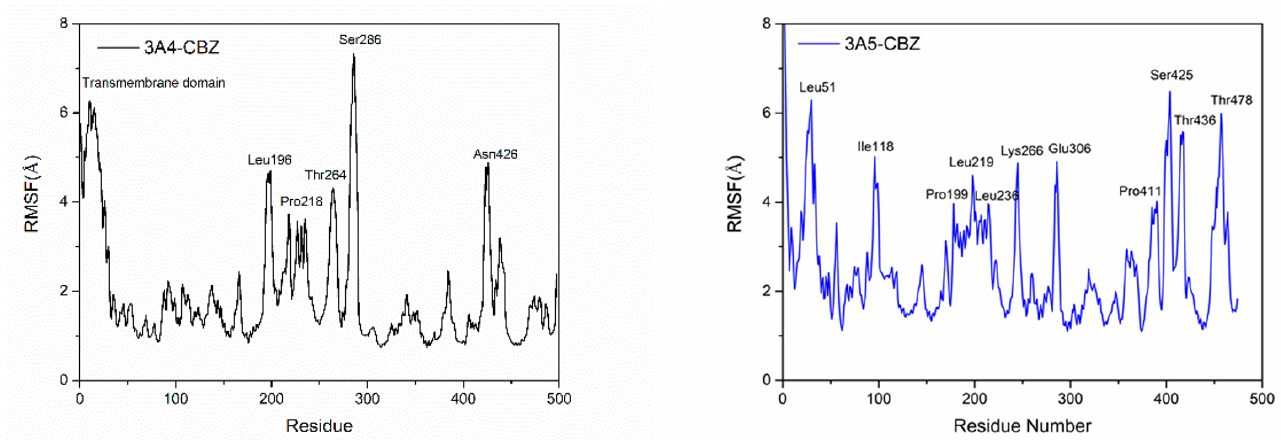
Figure 3. RMSF curve of all protein residues in the two complex systems, CYP3A4-CBZ ( left ) and CYP3A5-CBZ ( right ).